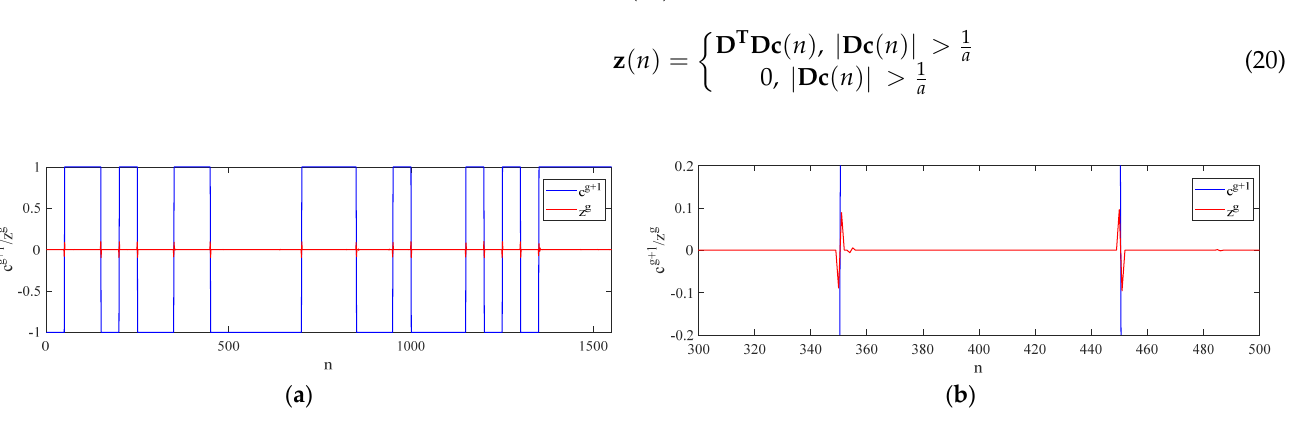
Figure 7. The response of the NCTVR: ( a ) global and ( b ) local .